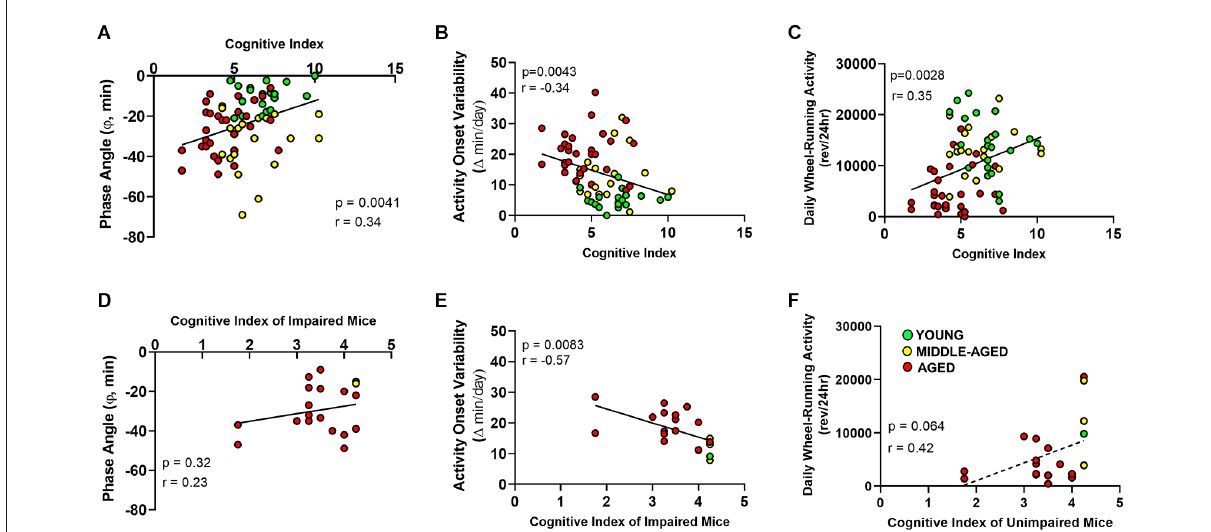
FIGURE5 Relationship between cognitive index acquired from Barnes maze and circadian entrainment properties of the activity rhythm. (A) The phase angle ( ϕ ) between daily activity onsets and lights-off; (B) absolute day-to-day variability in onsets of activity; and (C) total daily wheel-running activity (wheel revolutions/24 h) are correlated with Cognitive Index for young, middle-aged, and aged mice. Panels (D–F) show the same circadian measures as in (A–C) , however only for learning-impaired. Circles indicate individual scores of each mouse (young n = 1, middle-aged n = 3 and aged n = 16). Activity onset variability, but not phase angle of entrainment or total wheel-running activity, of learning-impaired mice are negatively correlated ( r = − 0.57) with cognitive index.